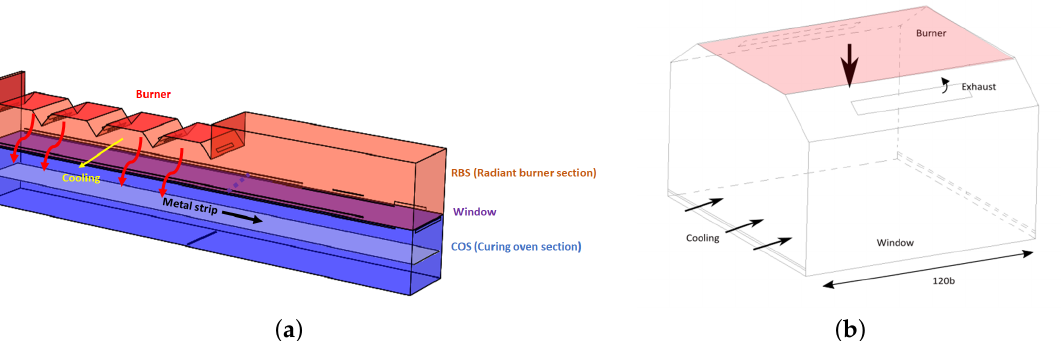
Figure 1. Three-dimensional physical models of the coil coating oven: ( a ) full radiative oven configu- ration; and ( b ) simplified radiant burner section geometric model considering a battery of burners with a single row of